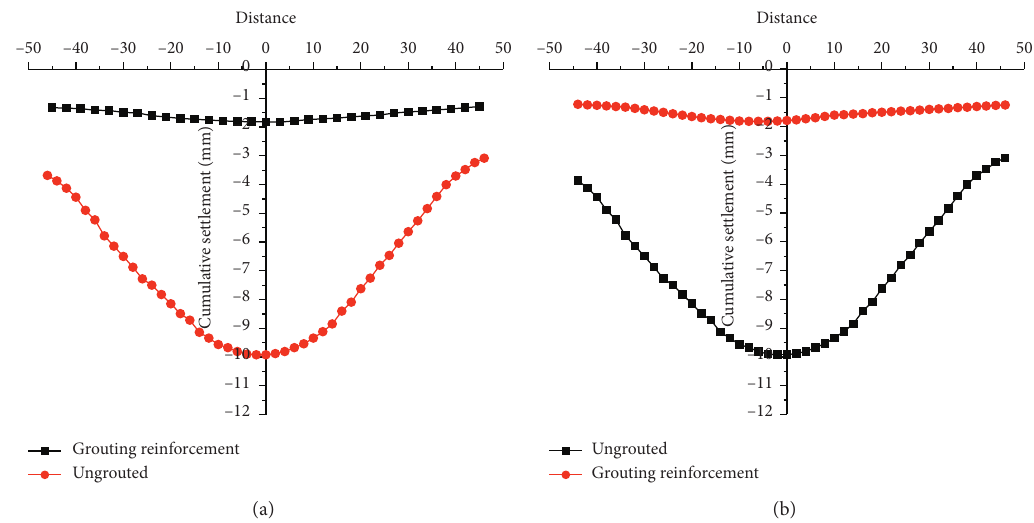
Figure 22: Comparison of settlement between subgrade and track before and after grouting. (a) Subgrade structure. (b) track structure. Table 3: Comparison of monitoring results and numerical simulation. Reinforcement